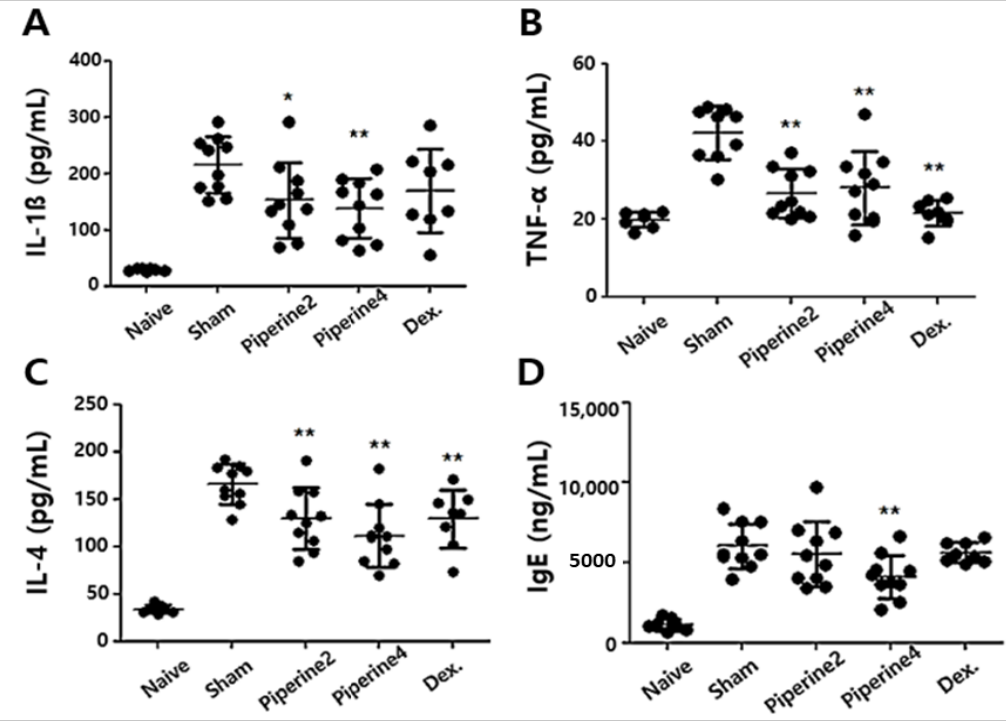
Figure 3. E ff ect of piperine on TMA-induced inflammatory cytokines and allergic responses. Production of ( A ) IL-1 β , ( B ) TNF- α , and ( C ) IL-4 cytokines in the ear and ( D ) IgE levels in the serum were analyzed using ELISA. The results are shown as the means ± SD (Naïve, n = 7; Sham, Piperein2 and 4, n = 10; Dex., n = 8). Asterisks (*) and (**) indicate significant di ff erences between piperine-treated groups and sham groups of TMA-induced AD-like mice at p < 0.05 and p < 0.01, respectively.